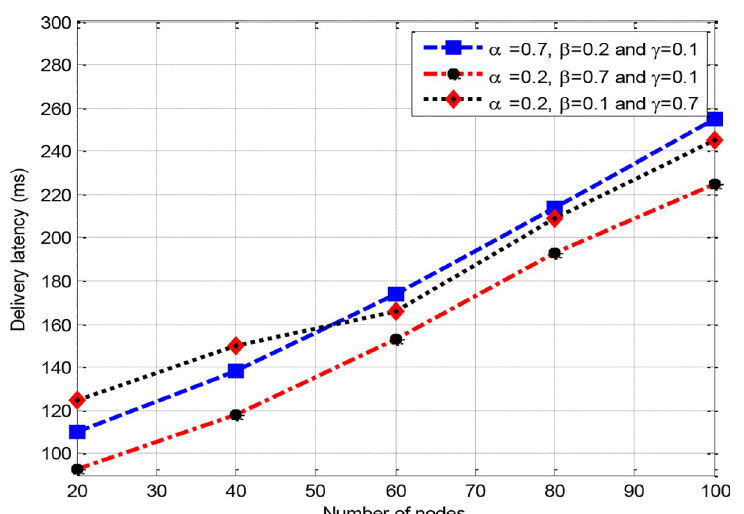
Fig 6. The impact of a number of nodes on delay